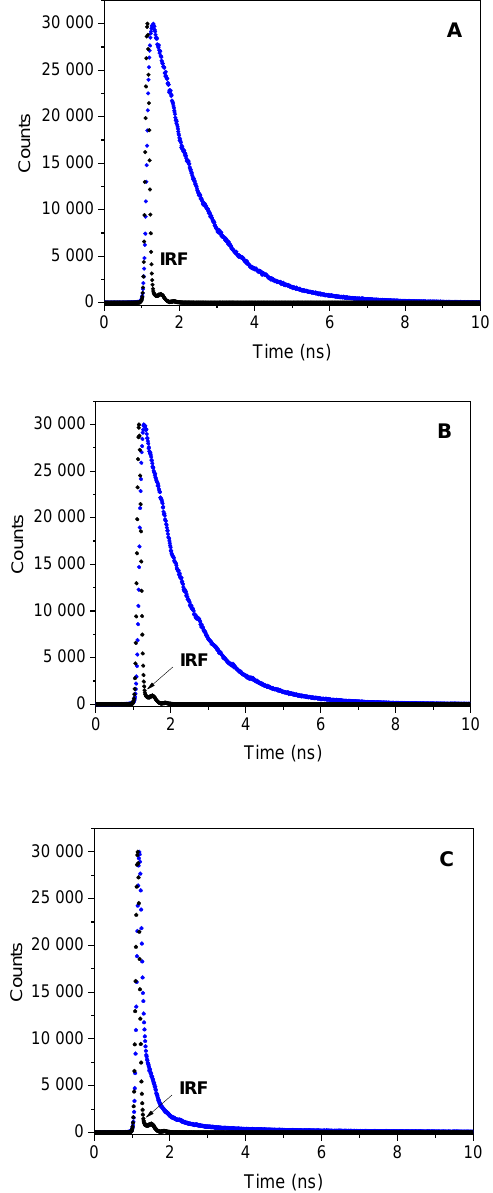
Figure 3. Fluorescence decay curve for (from top to bottom) P1 ( A ), P2 ( B ), and P3 ( C ), respectively, recorded in CHCl 3 ; λ ex = 373 nm; λ em = 460 nm